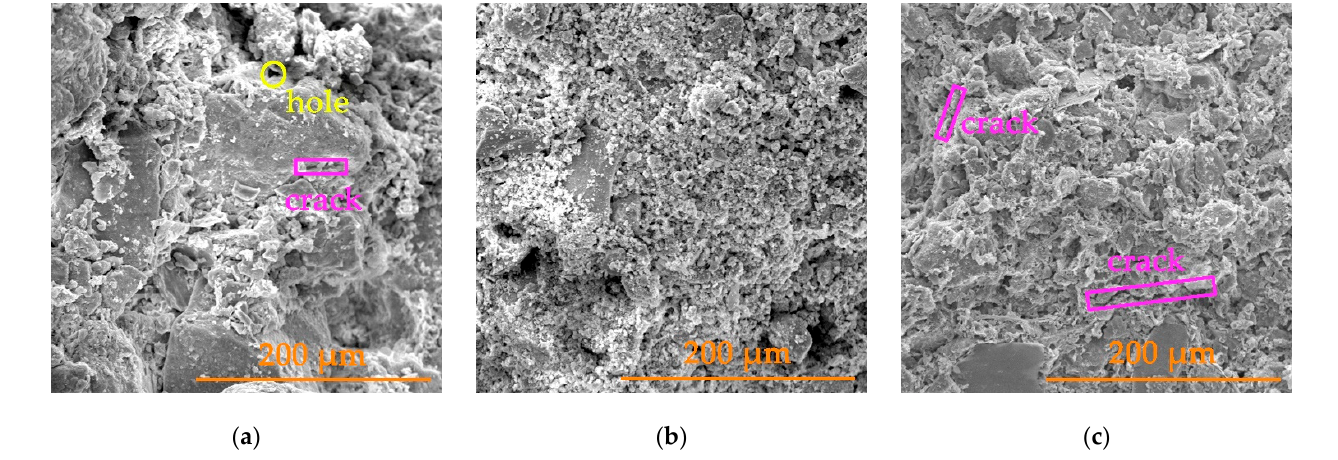
Figure 7. SEM images of a gray brick with a moisture content of 100% under different cycles: ( a ) the 0th freeze–thaw cycle; ( b ) the 30th freeze–thaw cycle; ( c ) the 55th freeze–thaw cycle.